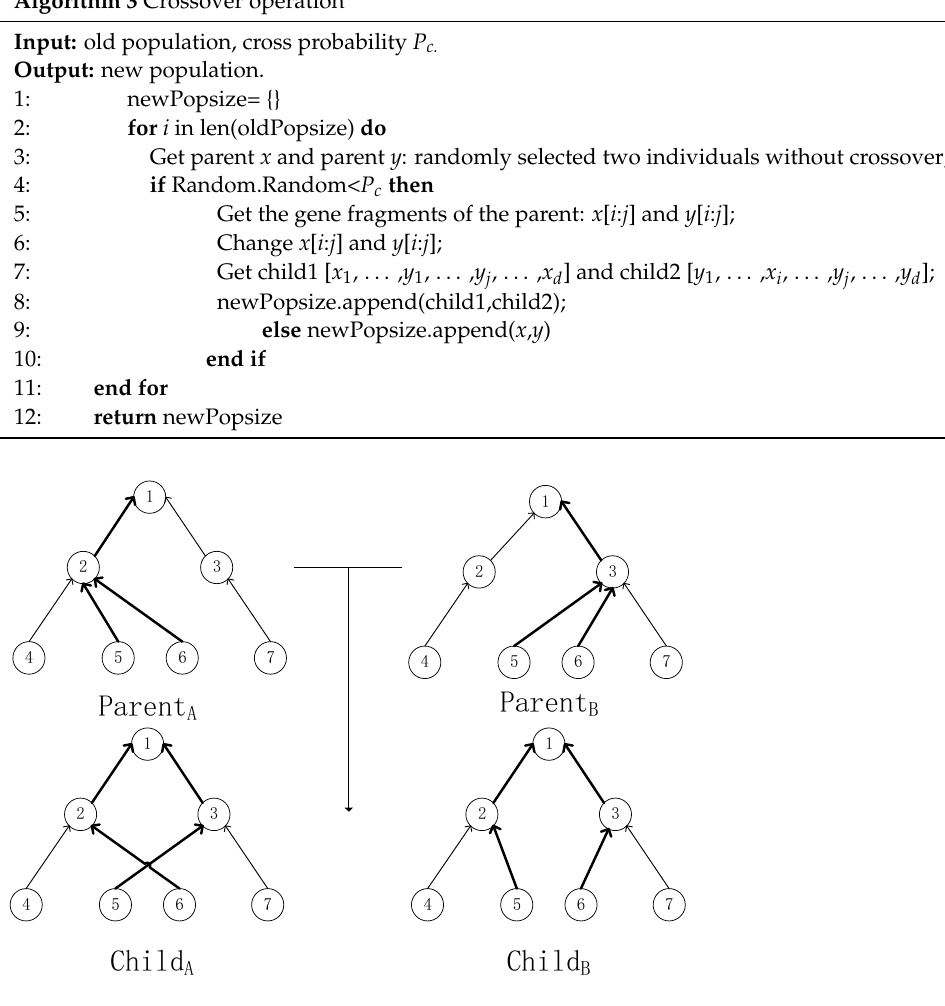
7 Figure 7. Topology loop after the cross operation. According to the previous analysis, it is best to achieve the effect of repairing the local minimum flow at the same time when correcting the infeasible solution, that is, after de looping, the maximum weight of the edge of the spanning tree is the smallest among all spanning trees, which is the bottleneck spanning tree of the graph. Therefore, only the bottleneck spanning tree of the graph corresponding to the infeasible solution is required; this can be accomplished by solving the minimum spanning tree. The following theorems and proofs ensure that the de looping operation designed in this paper can not only cor- rect the infeasible solution but also achieve the local repair flow optimization. Theorem 1. The minimum spanning tree must be the bottleneck spanning tree.